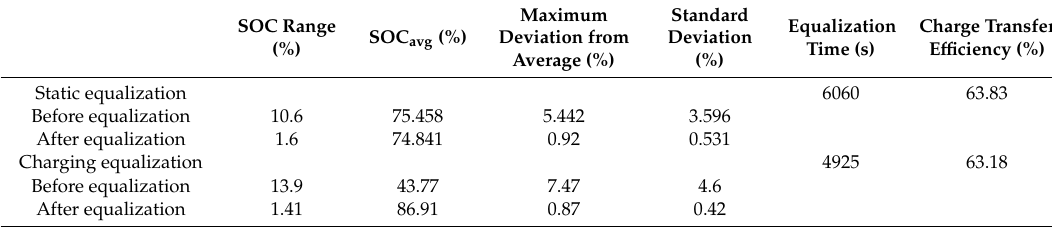
Table 4. Consistency comparison of retired battery pack before and after